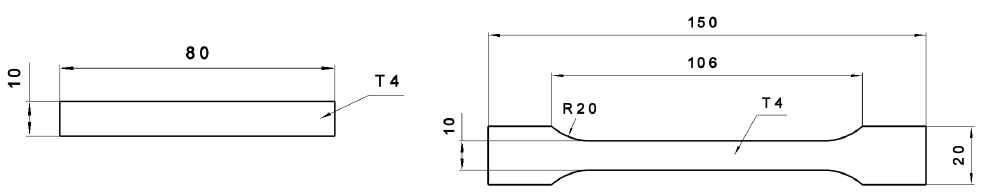
Figure 2. Dimensions of testing specimen: type 1 ( left ) and type 1A ( right